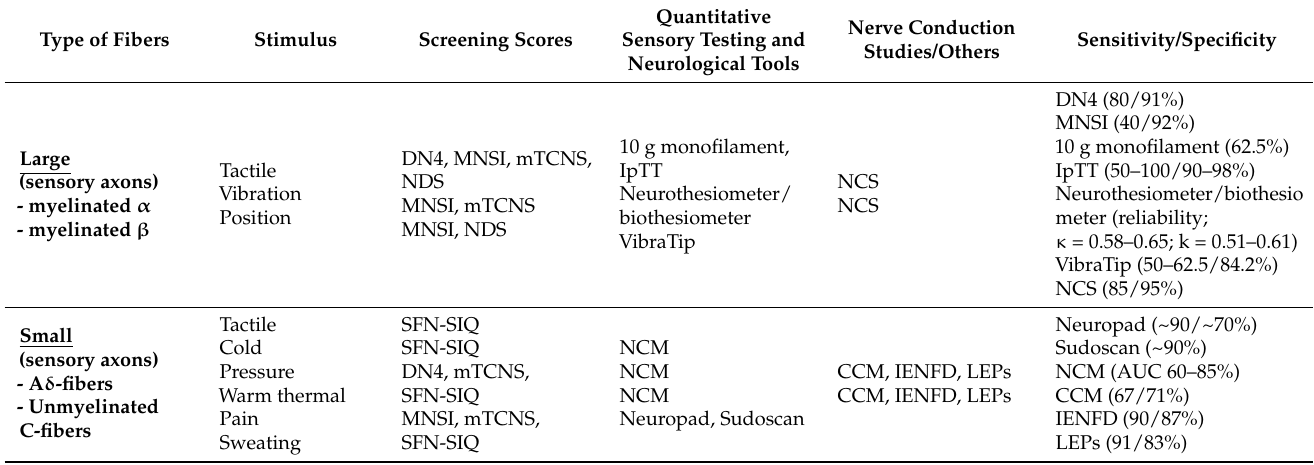
Table 1. Dolor neuropatique 4; MNSI, Michigan Neuropathy Screening Instrument; mTCNS, modi- fied Toronto Clinical Neuropathy Score; NDS, Neuropathy Disability Score; SFN-SIQ, Small Fiber Neuropathy and Symptoms Inventory; Questionnaire; IpTT, Ipswich touch test; NCM, Nervecheck Master; NCS, Nerve Conduction Studies; CCM, Corneal Confocal Microscopy; IENFD, intraepidermal nerve fibers density; LEPs, laser evoked